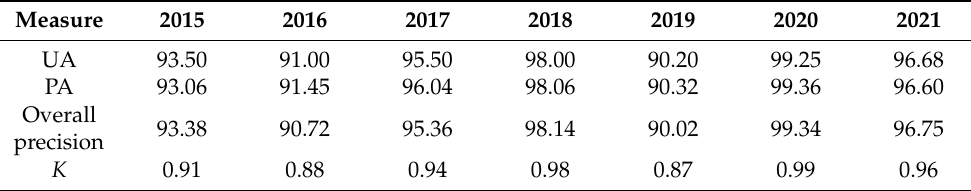
Figure 7. Annual precipitation in Coatzacoalcos, Veracruz. Source: Comision Nacional del Agua (CONAGUA) [74]. Table 8. Overall precision and Kappa coefficient ( K ) for macro-class-based